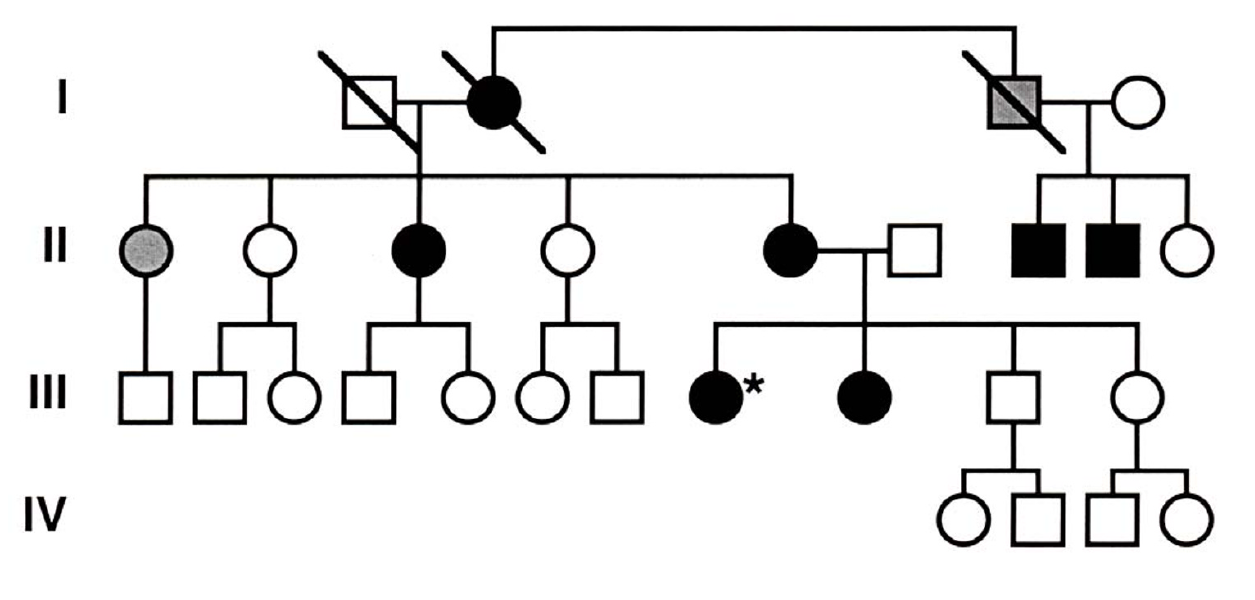
Pedigree Shown is the pedigree ascertained from the proband (indicated with an asterisk). Affected individuals are shown in black. Each affected individual had undergone pacemaker implantation for bradycardia. Shown in gray are individuals with a his- tory of heart disease or sudden